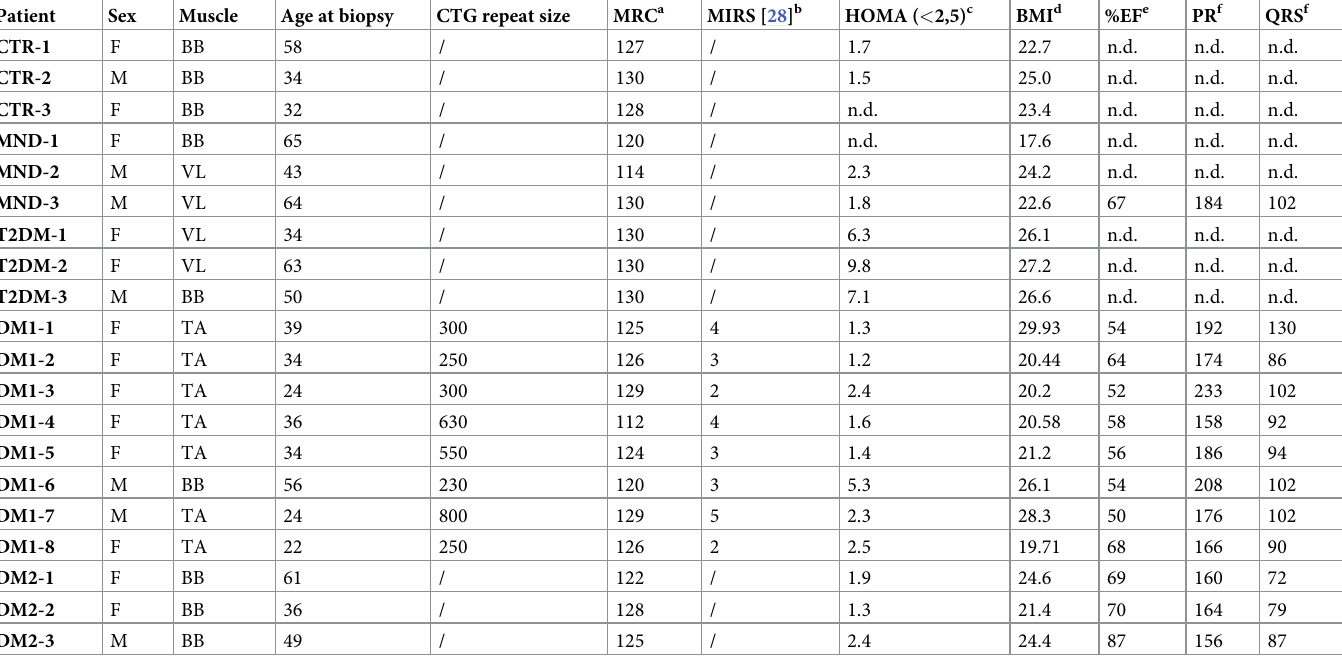
Table 1. Clinical data on CTR, MND, T2DM and DM patients used in this study.